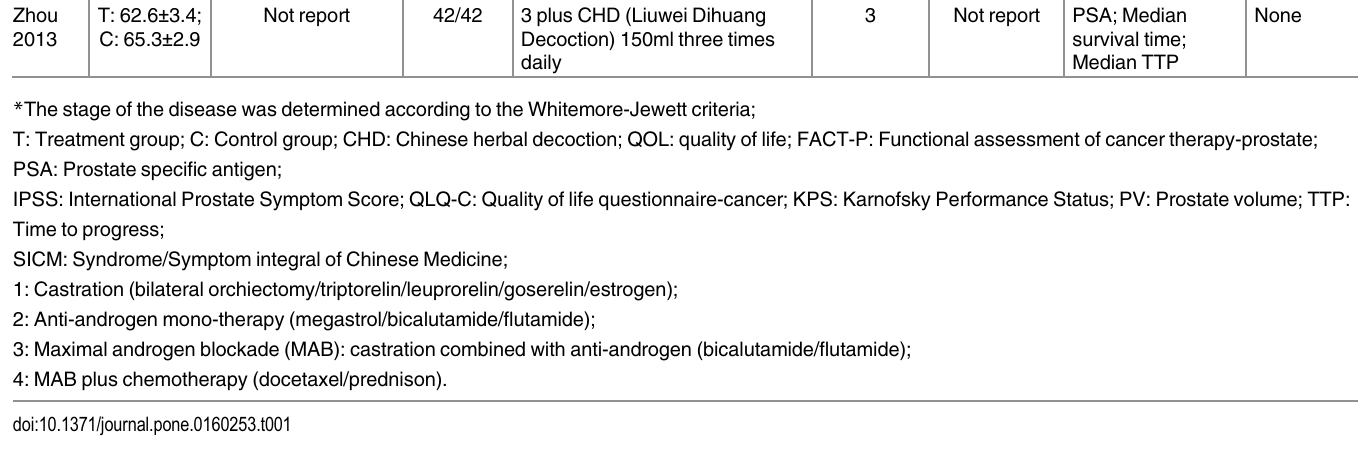
anti-androgen mono-therapy, or maximal androgen blockade (MAB). Estrogen